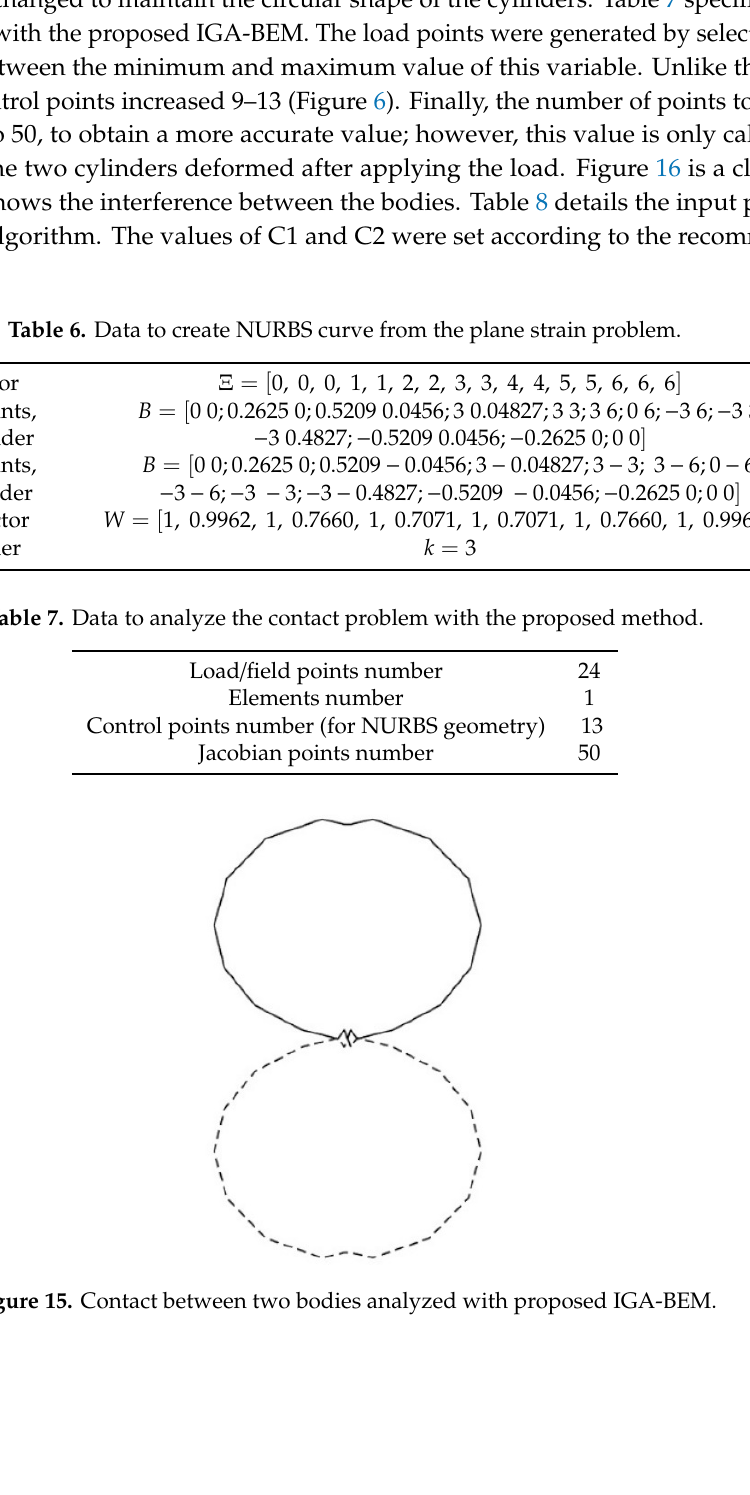
Table 4. Data to create NURBS curve from the plane strain problem.